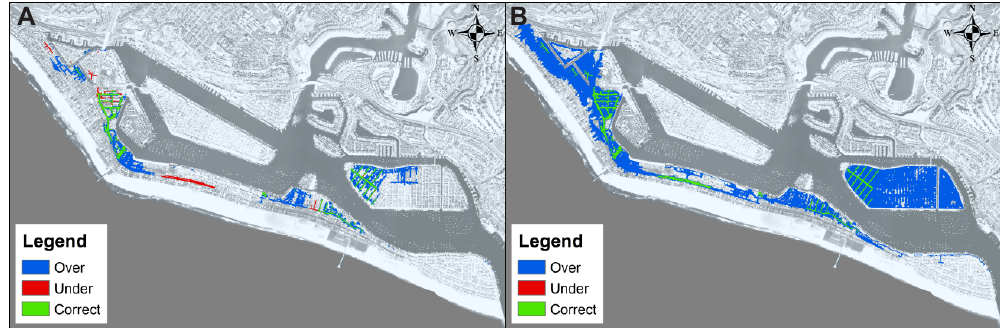
Figure 3. Validated flood prediction with: ( A ) the wall resolved with an RTK survey; and ( B ) original LiDAR data which does not capture the wall elevation. Adapted from Gallien et al.